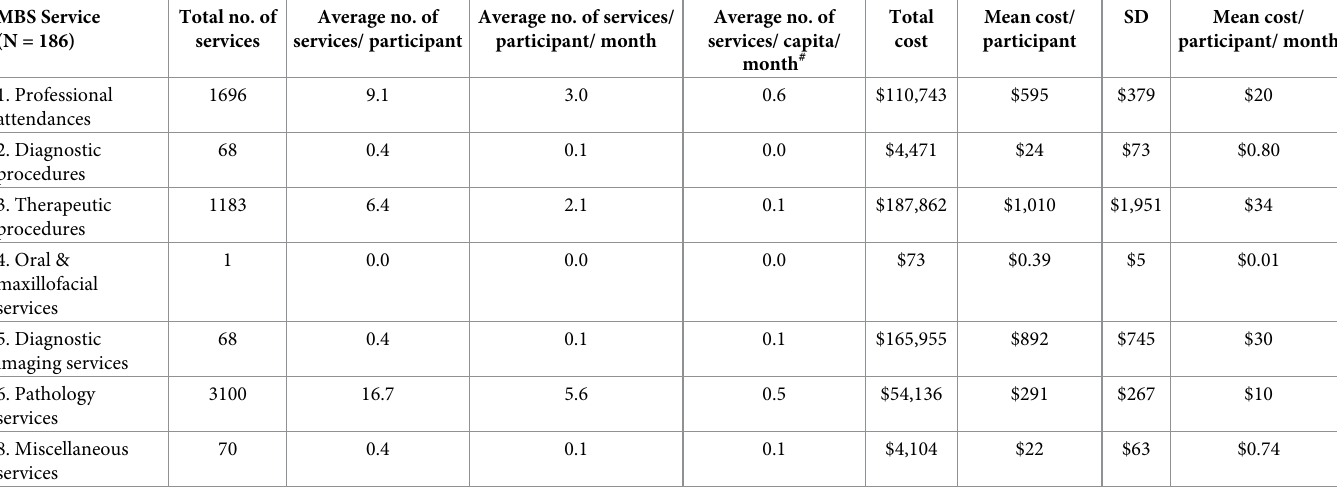
Table 2. Medicare benefits schedule service use and costs in the three months prior to